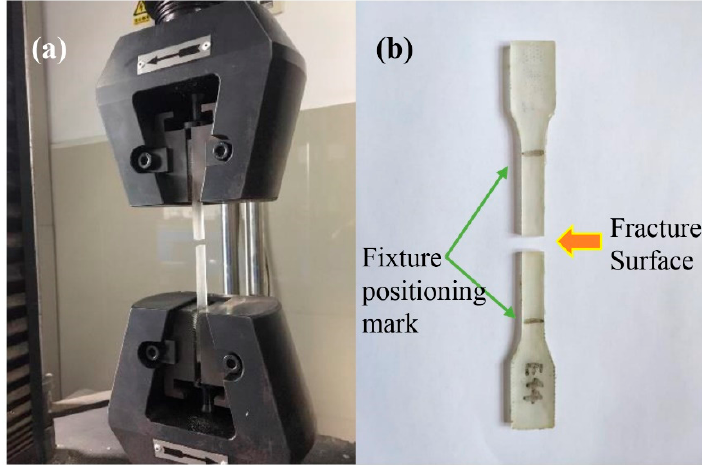
Figure 7. Tensile test results. ( a ) Test process. ( b ) Fractured specimen in the test. Table 4. Tensile test data.